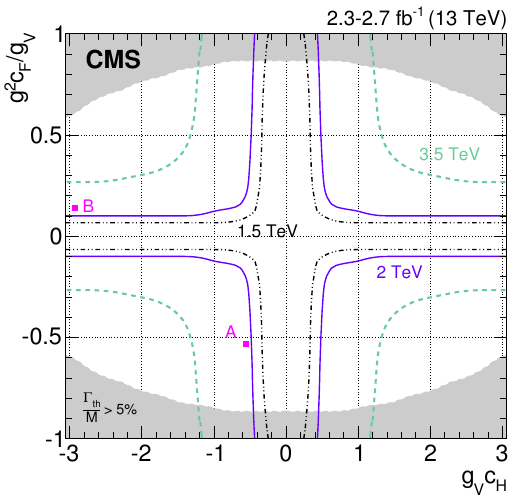
Figure 7 . Exclusion regions in the plane of the HVT couplings ( g 2 c F =g V ; g V c H ) for three resonance masses, 1.5, 2.0, and 3.5 TeV. Model points A and B of the benchmarks used in the analysis are also shown. The solid, dashed, and dashed-dotted lines represent the boundaries of the regions excluded by this search for di(cid:11)erent resonance masses (the region outside these lines is excluded). The areas indicated by the solid shading correspond to regions where the resonance width is predicted to be more than 5% of the resonance mass and the narrow-resonance assumption is not satis(cid:12)ed. that the new resonance is narrow. A contour is overlaid, representing the region